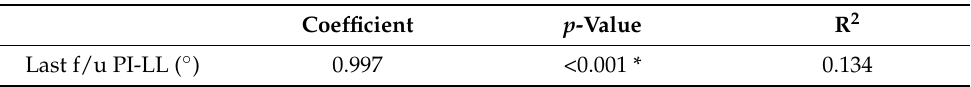
Table 4. Stepwise multiple regression analysis of influencing factors of last follow-up achievement of optimal alignment.